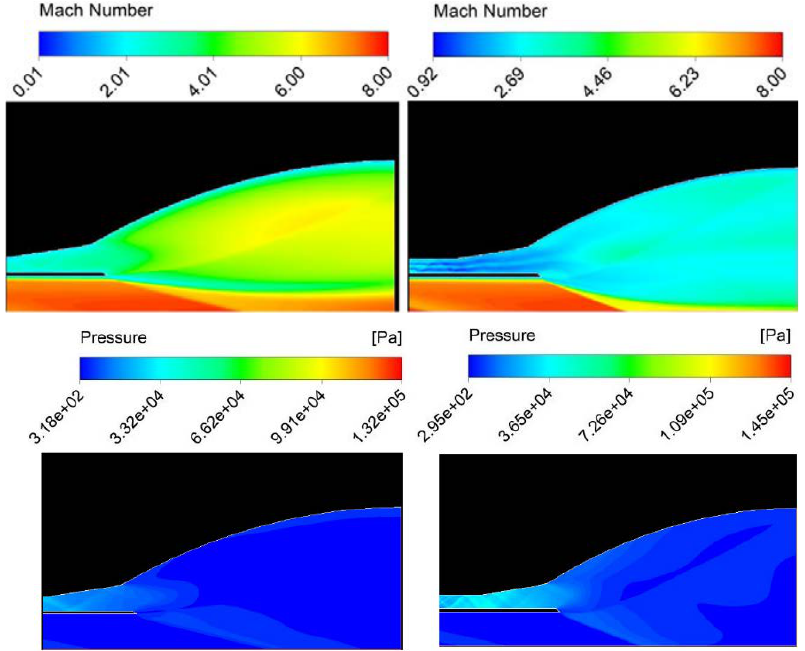
Figure 19. Mach number ( top ) and pressure contours ( bottom ) of DP102 for cold flow ( left ) and hot flow ( right ).